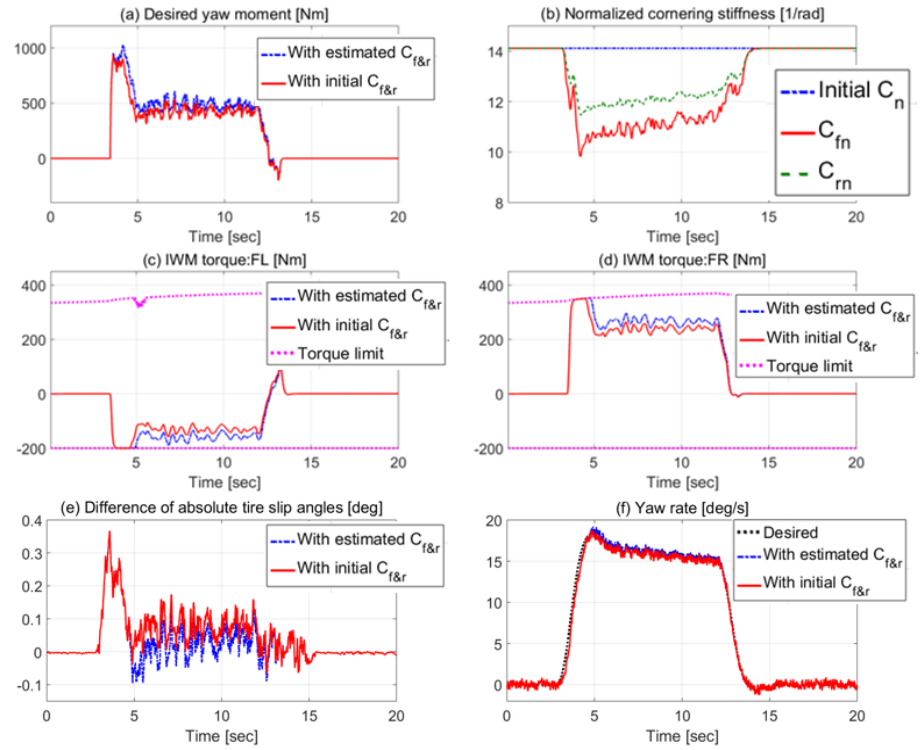
Figure 8. Simulation results of circle turn test (vs. model-based controller with initial 𝐶 𝑓0&𝑟0 ). ( a ) Desired yaw moment. ( b ) Normalized cornering stiffness. IWM torques: ( c ) FL, and ( d ) FR. ( e ) Difference of absolute tire slip angles. ( f ) Yaw rate. Table 2. Comparison of controllers (simulation results).